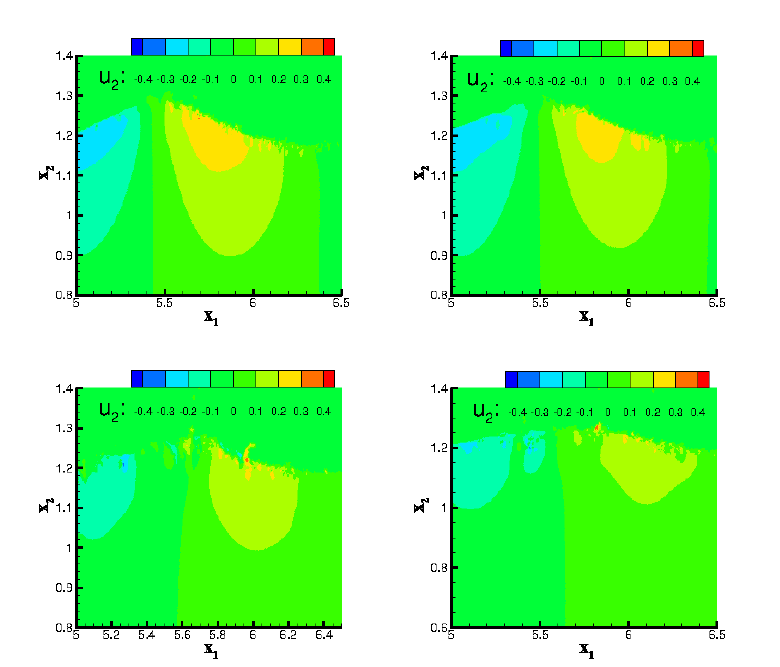
Figure 7. Instantaneous snapshot of wall-normal velocity component ( u 2 [m/s]) at t = 5 [s] ( left-hand side panels ) t = 10 [s] ( right-hand side panels ). The top panels correspond to the case with the wind body force f = 0.5 [N/M] and bottom panels correspond to the case with the wind body force f = 0.6